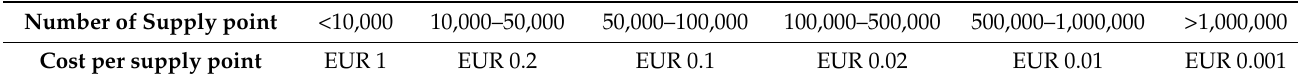
Table 5. A basis for DSO’s willingness to pay for the software as a service fee.